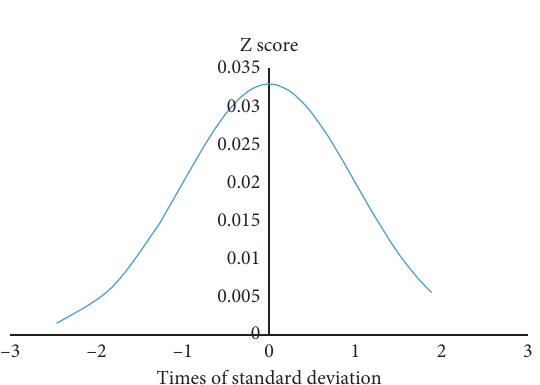
Figure 3: Distribution of SD − .